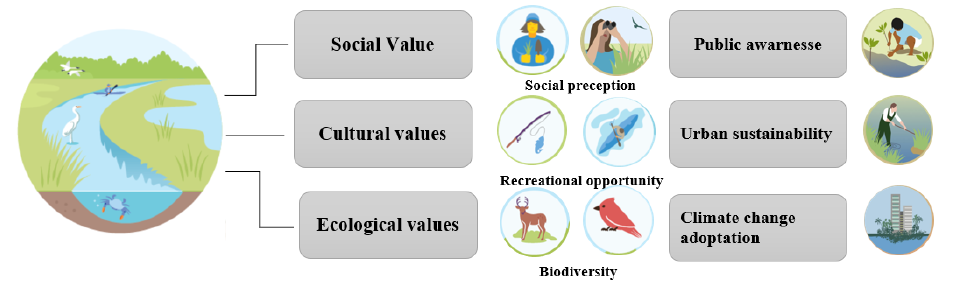
Figure 1. Ecological and cultural values offered by urban wetlands.